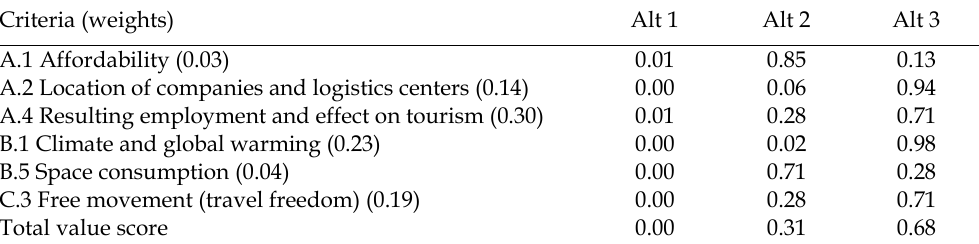
Table 13. Assessment scores - Sustainable development Criteria